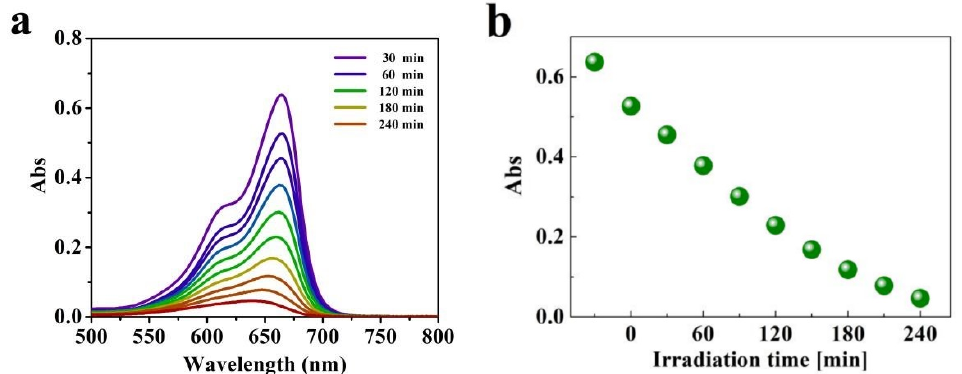
Figure 11. ( a ) Absorbance changes of Ag 2 NCN nanorods for MB photocatalytic degradation; ( b ) the photocatalytic kinetics of the Ag 2 NCN nanorods.